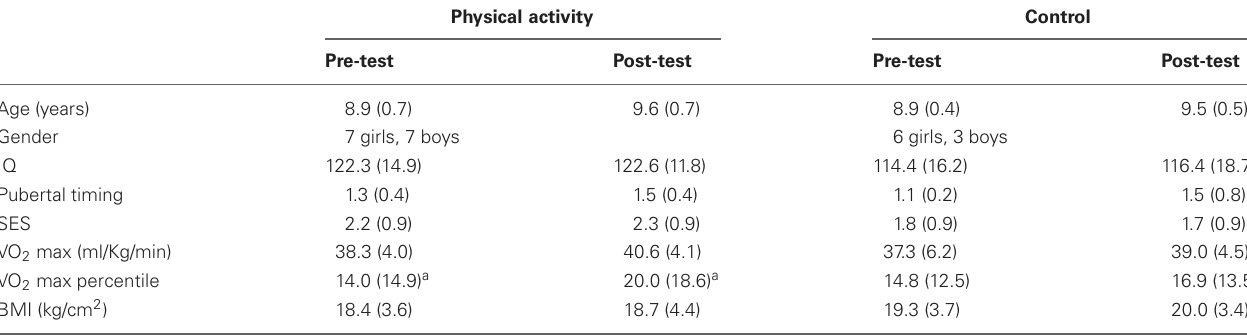
Table 1 | Mean (SD) for physical activity and control groups at pre-test and post-test.